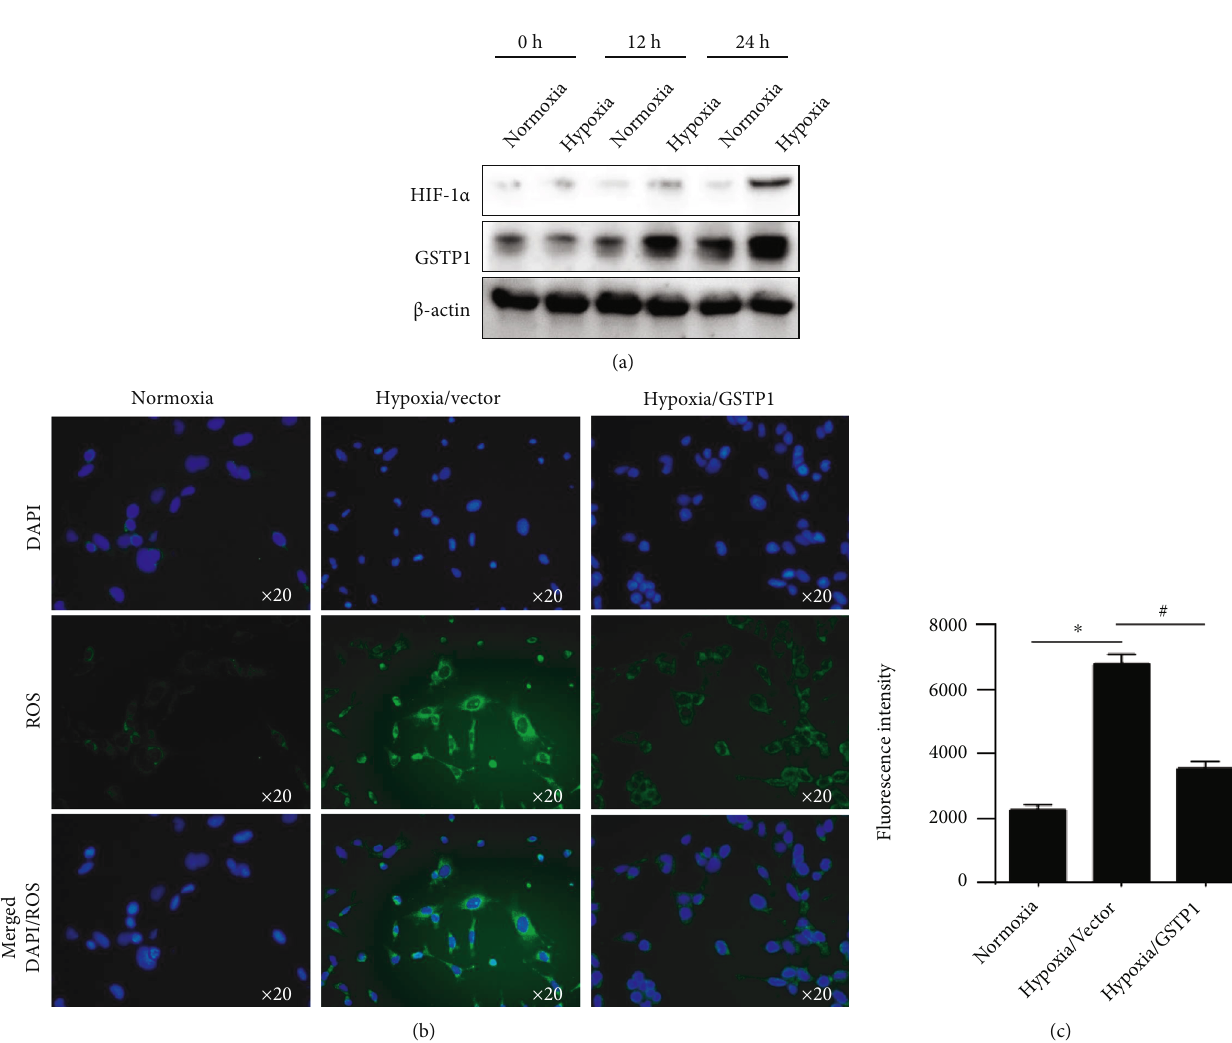
Figure 3: GSTP1 is induced by hypoxia exposure and scavenged ROS. (a) After being culture in normoxia or hypoxia for 12 or 24 hours, western blot was performed to detect HIF-1 α and GSTP1 protein levels. (b) After being cultured under normoxia or hypoxia with overexpressed GSTP1, intracellular ROS was stained and imaged by using Olympus x71 microscope. (c) Accumulation of ROS was measured quantitatively. * P < 0 : 05 , vs. normoxia group; # P < 0 : 05 , vs. hypoxia/vector